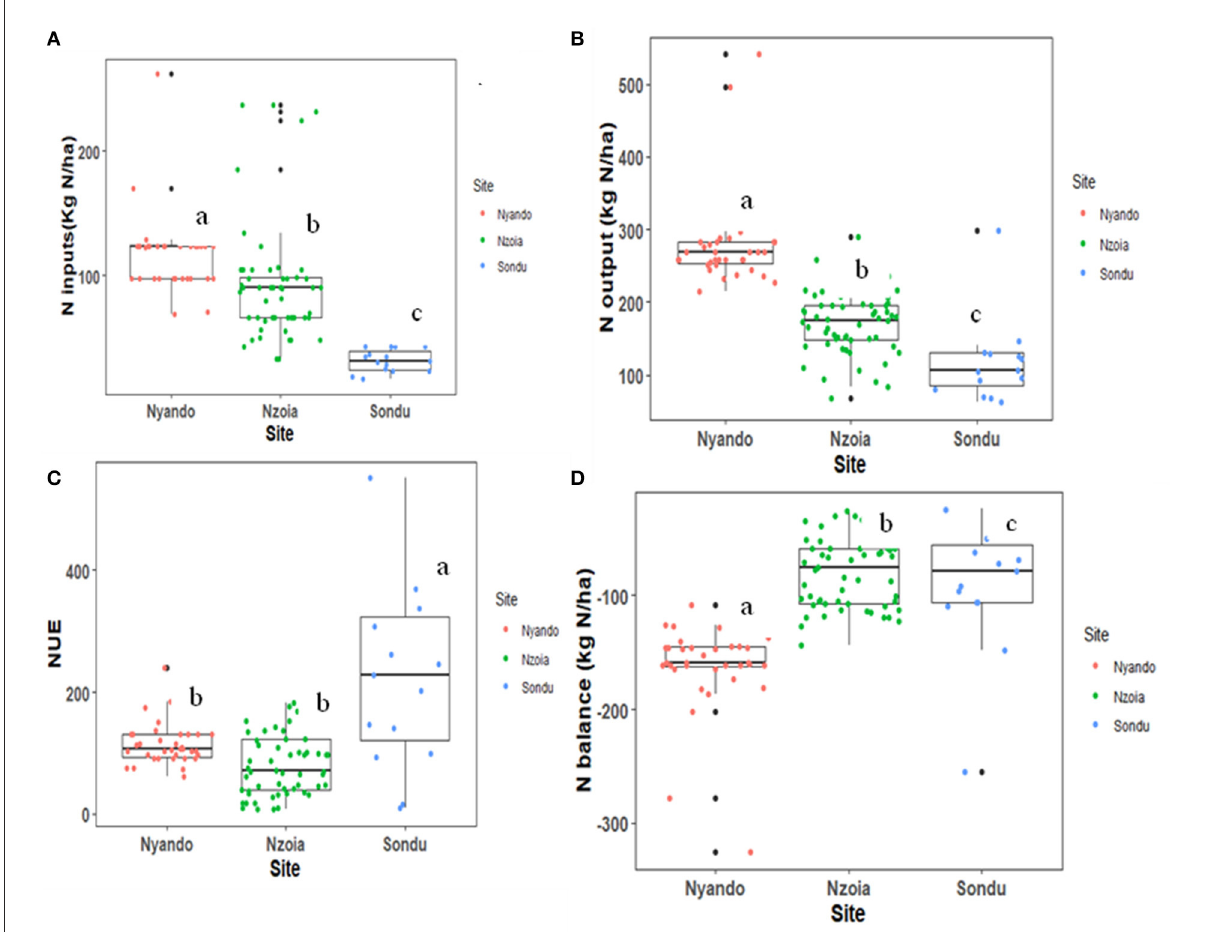
both fields with and without the application of mineral N fertilizers. This could be due to different soil properties in the regions characterized and defined by Ntinyari et al.